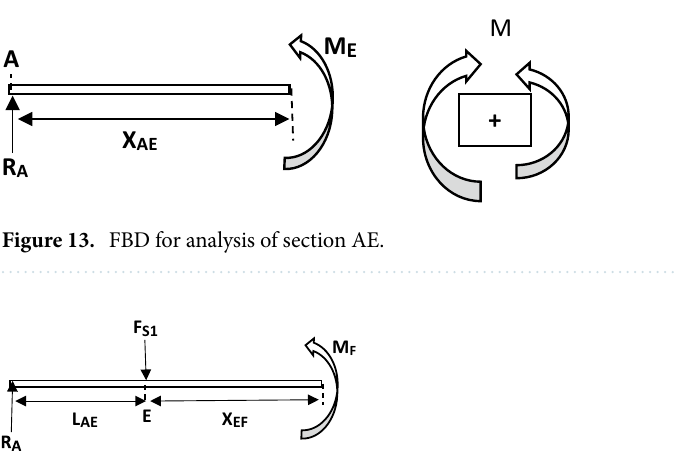
Figure 14. FBD for analysis of section